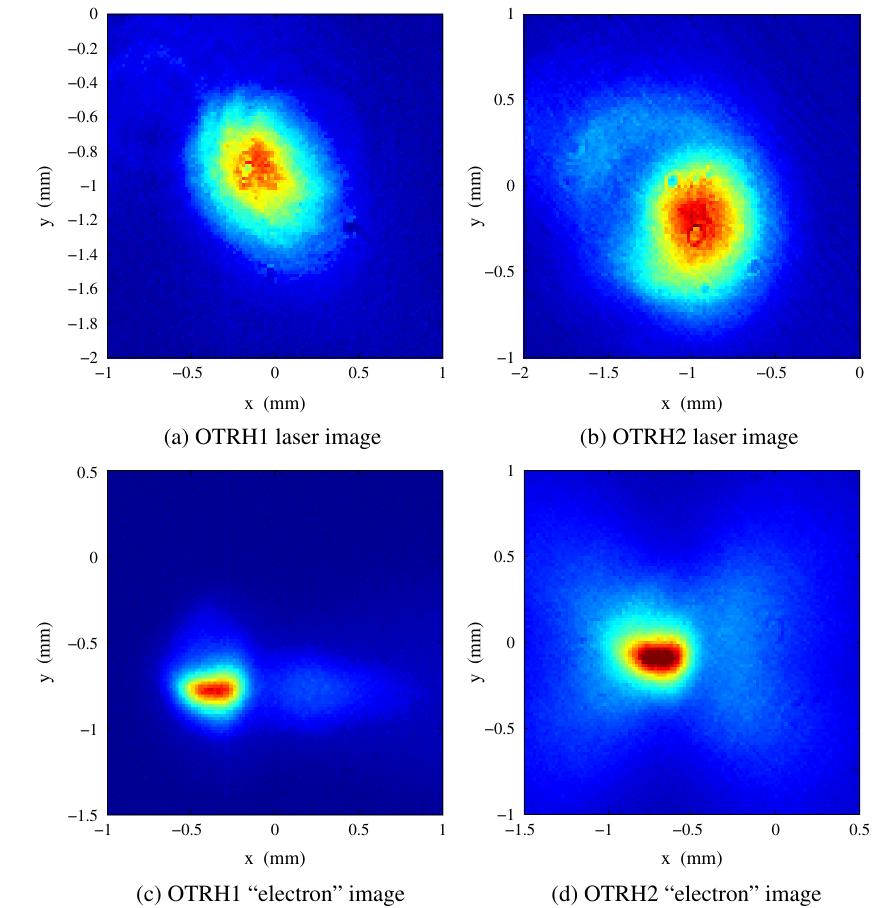
FIG. 3. (Color) Beam images on LH OTR screens (OTRH1 and H2) before transverse alignment, see text for